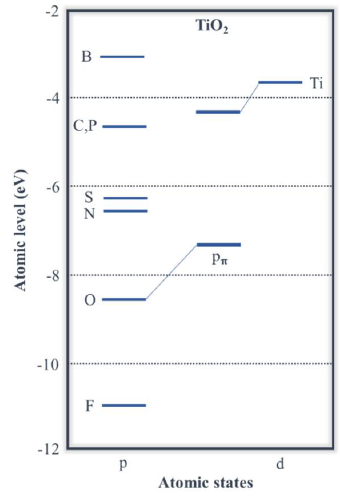
Figure 5. Comparison of atomic p levels of different anions (Adapted from [65]).